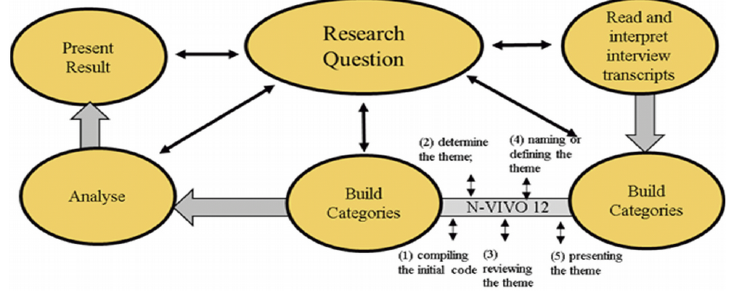
Figure 1. Data Analysis Flow